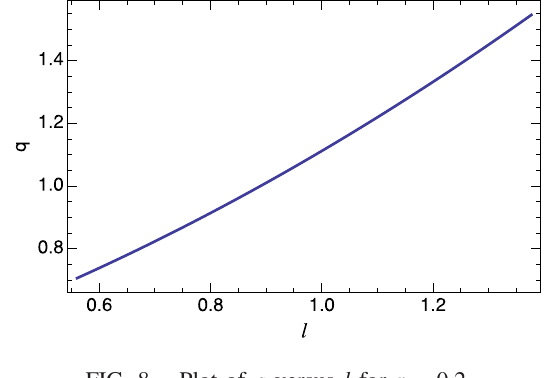
FIG. 8. Plot of q versus l for r ¼ 0 . 2